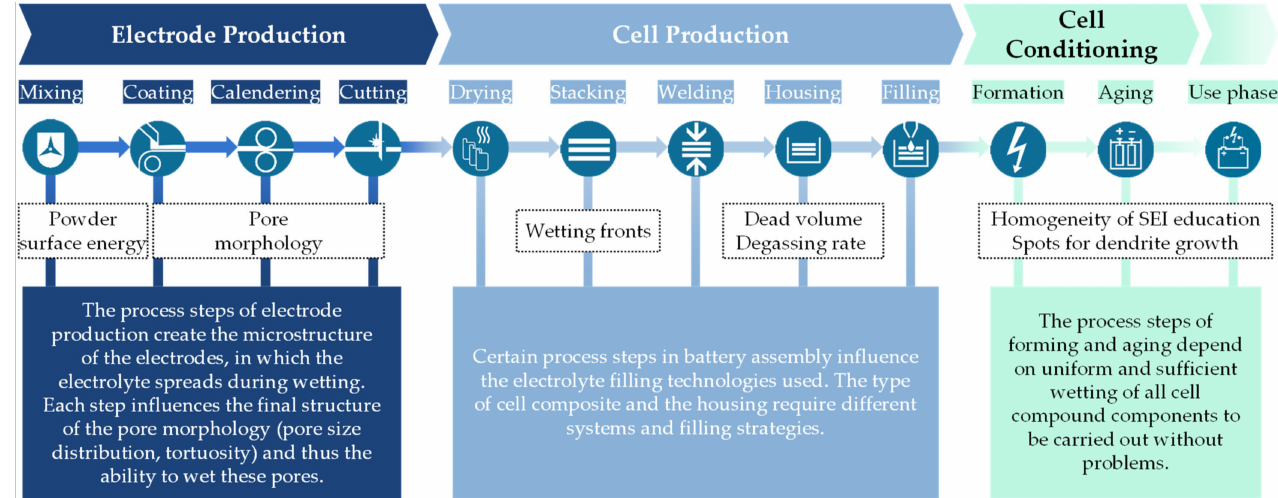
Figure 2. Schematic illustration of the process chain of battery cell production with the state-of-the-art process steps. The dashed boxes show the properties relevant to wetting, which are influenced by this particular process